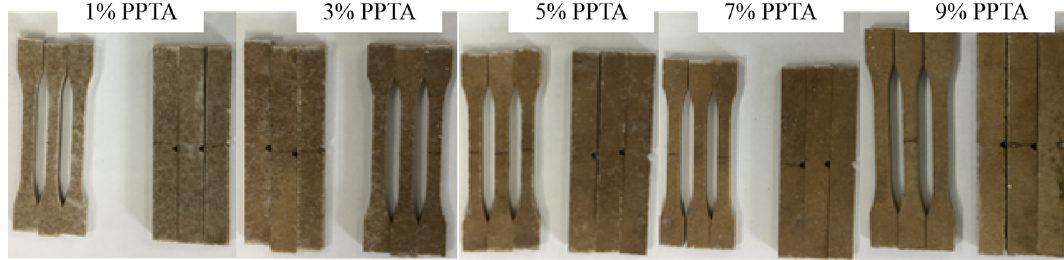
Figure 5. Test sample of PPTA and nano Al 2 O 3 filled modified PTFE composite material.